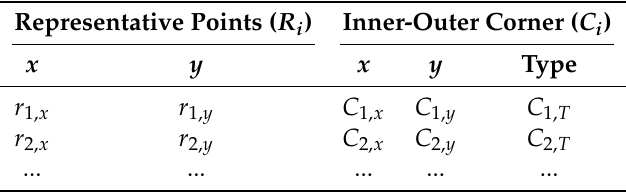
Figure 12. Contour pixel reconstruction. ( a ) Representative points and inner-outer corner points; ( b ) cases of the proposed algorithm. Table 3. Data structure of the proposed contour